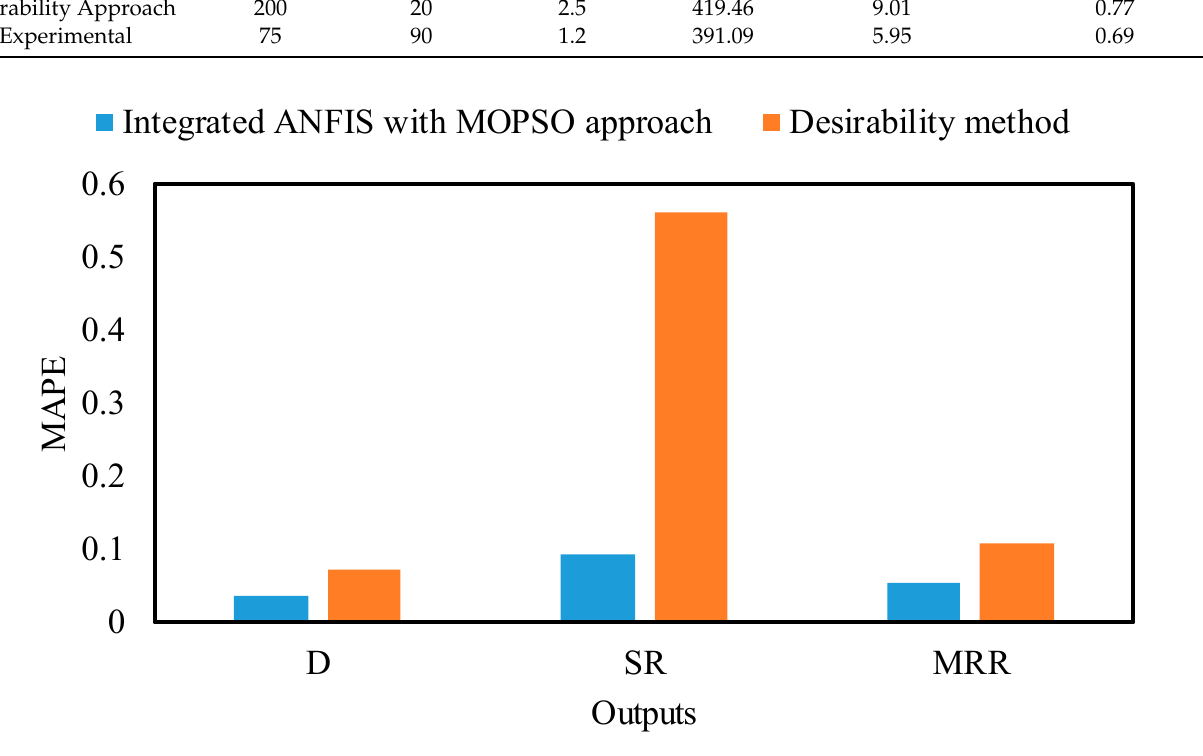
Figure 16. SEM picture of the fabricated microchannel using the optimized GnP reinforcement ratio and laser micromachining parameters . 4. Conclusions The reported studies in the literature on optimizing GnP ratio and microfabrication parameters to enhance the micromachining performance of monolithic Al 2 O 3 are still rare and incomplete. To overcome this, GnPs/Al 2 O 3 nanocomposites with varying GnP gra- phene contents of 0.5 wt.%, 1 wt.%, 1.5 wt.%, and 2.5 wt.% were successfully produced using ball mill powder processing and the HFIHs process. Afterward, micromachining experiments were conducted using low-power laser technology to investigate the in fl u- ences of graphene reinforcement ratio, scanning speed, and frequency on the D, SR, and MRR of the Al 2 O 3 nanocomposites. After that, an integrated arti fi cial method based on an ANFIS–MOPSO approach was developed to optimize the laser microfabrication pro- cessing and GnP reinforcement ratio to improve the quality of the fabricated microchannel